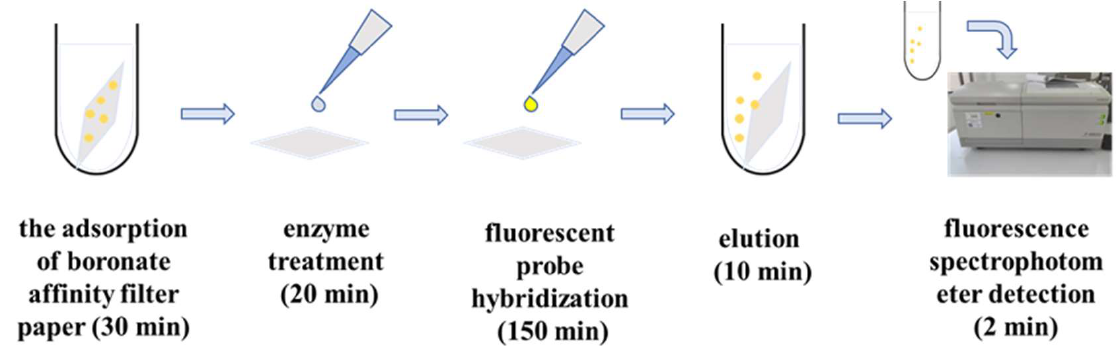
Figure 10. Flow chart of the process of enrichment to detection of pathogenic bacteria.